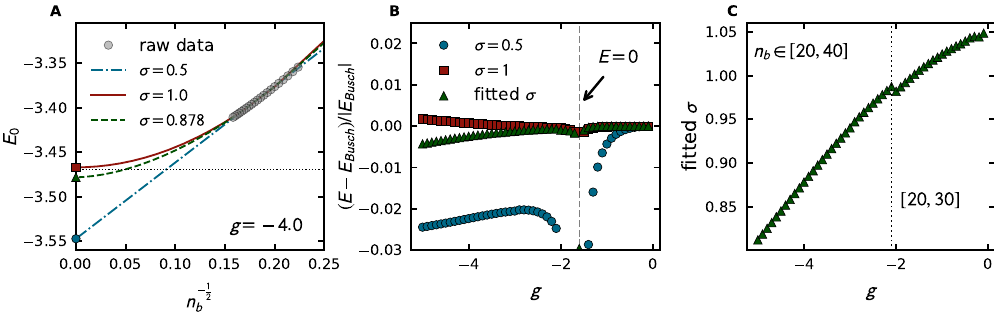
Figure 8: Extrapolation of effective interaction results without magnetic impu- rity for the 1 ↑ + 1 ↓ system . (A) Extrapolation of the ground-state energy to the → ∞ for g = − 4.0 for σ = 0.5 and 1.0 (blue dashed-dotted and red solid limit n b curves, respectively) as well as for open σ (green dashed curve). The black dashed line reflects the exact two-body solution. (B) Relative error of the extrapolated result with respect to the exact solution (color coding as in A). The vertical dashed line marks a zero-crossing of the ground-state energy. (C) Fitted values for σ when it is unconstrained as a function of the interaction strength g